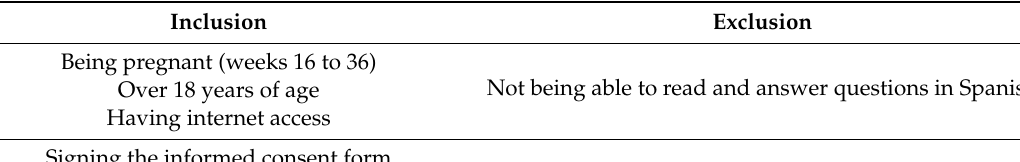
Table 1. Inclusion and exclusion criteria to participate in the